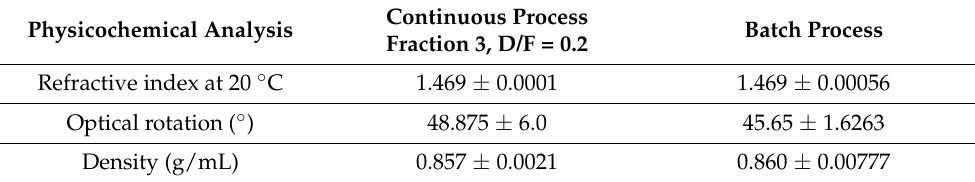
Table 2. Reference values for the physicochemical